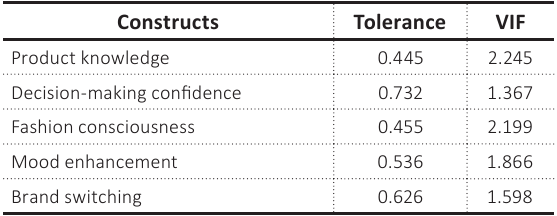
Table 3. Multi-collinearity diagnostics